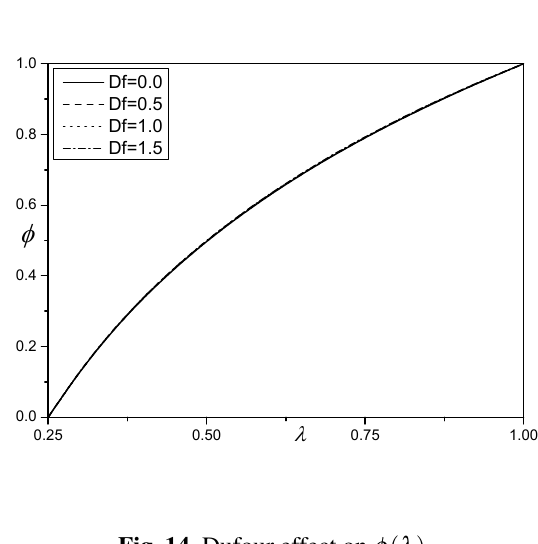
Fig. 14 Dufour effect on φ ( λ